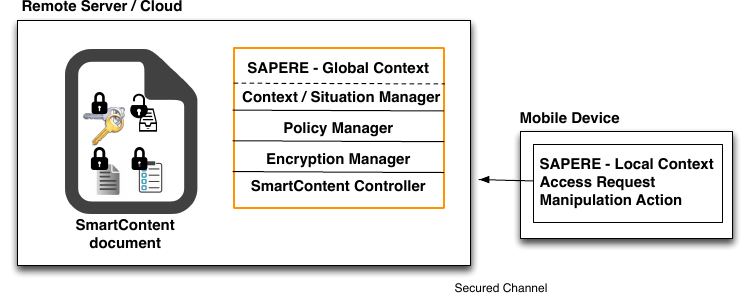
Figure 13. Documents stored and protected